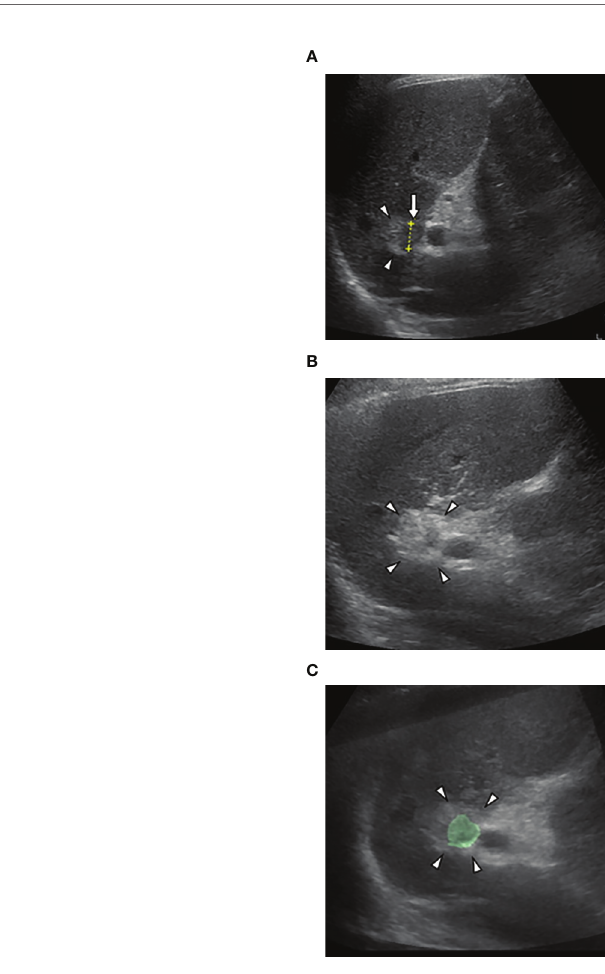
FIGURE 2 | US-US fusion imaging and US-US overlay fusion. (A) CT-US fused image shows locally progressed hepatocellular carcinoma (HCC) (arrows) touching ablative necrosis (arrow heads) due to previous ablation. (B) US-US fusion imaging displays HCC colorized as green before ablation (right) and ablative hyperechoic zone (arrowheads) due to the present ablaion (left). (C) US-US overlay fusion demonstrates the green colorized HCC inside the ablative hyperechoic zone concentrically.